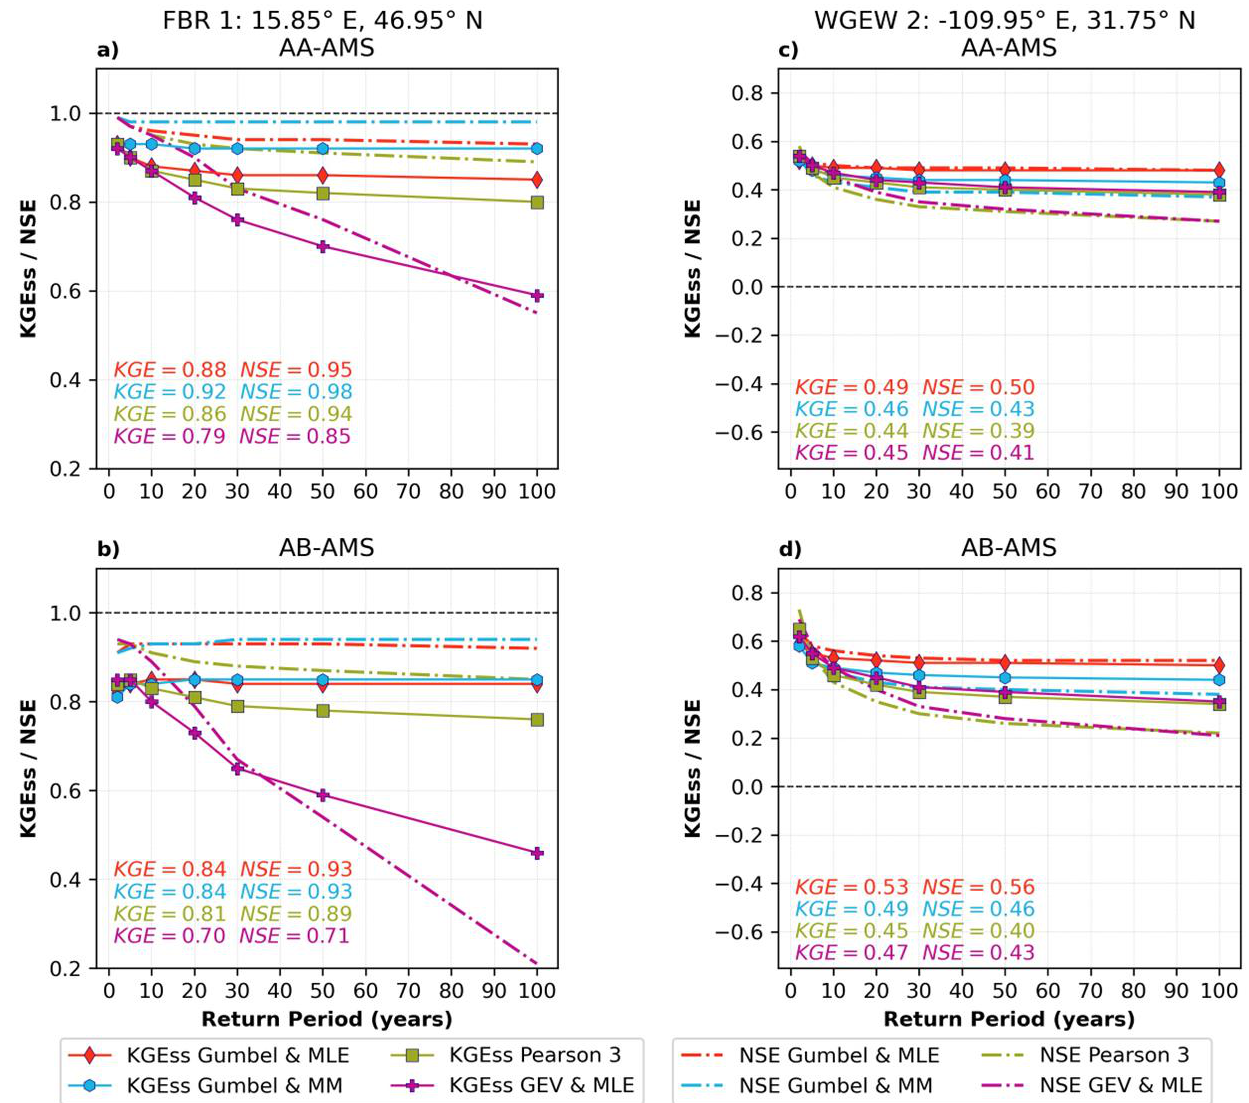
Figure A4. KGEss and NSE obtained for the four CDFs and the return periods 2, 5, 10, 20, 30, 50, and 100 years over FBR 1 ( left ) and WGEW 2 ( right ). IMERG IDF vs. AA-AMS IDF (subplots a , c ) and IMERG IDF vs. AB-AMS IDF (subplots b , d ). The solid lines with markers are for the KGEss and the dashed lines are for the NSE.